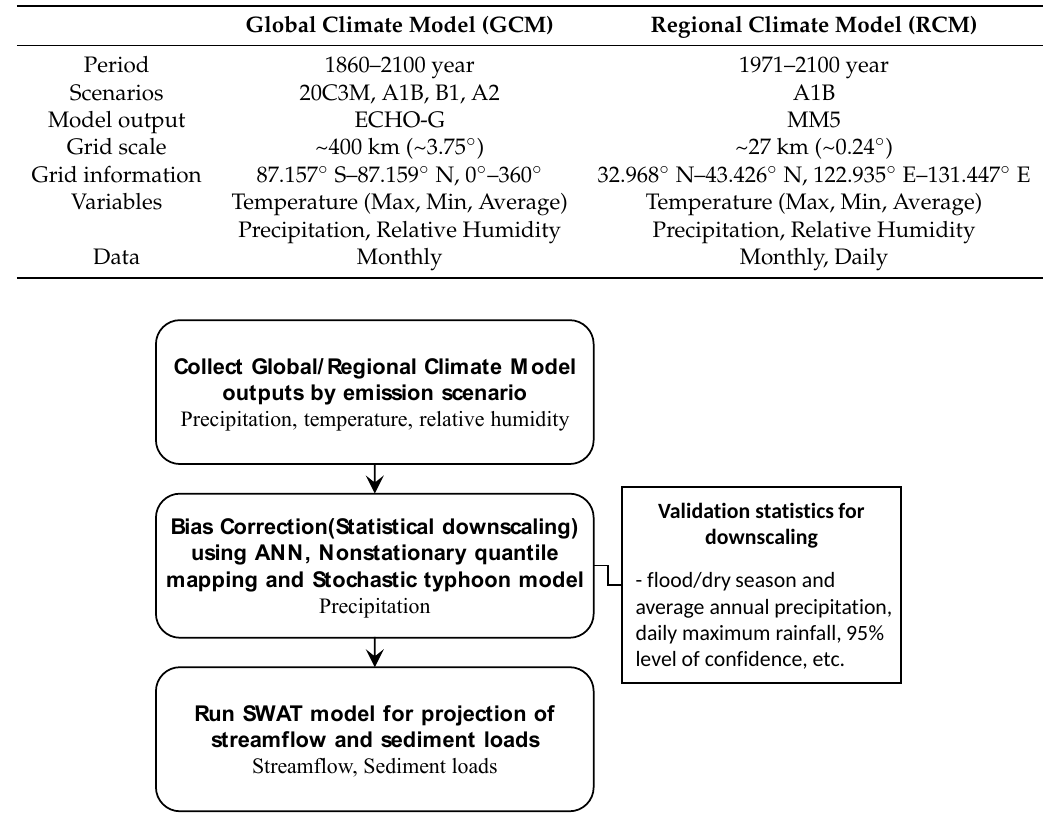
Figure 1. Schematic diagram for regional hydro-climatic